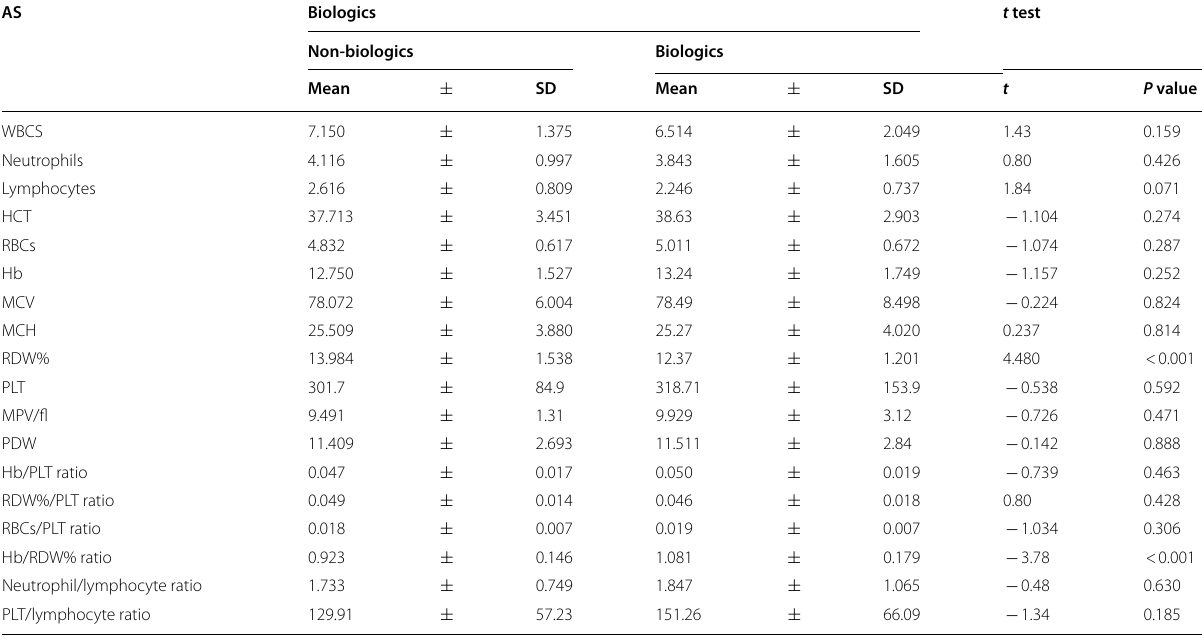
Table 4 Comparison between AS patients with and without biologic therapy as regards WBCs, RBCs, and platelets